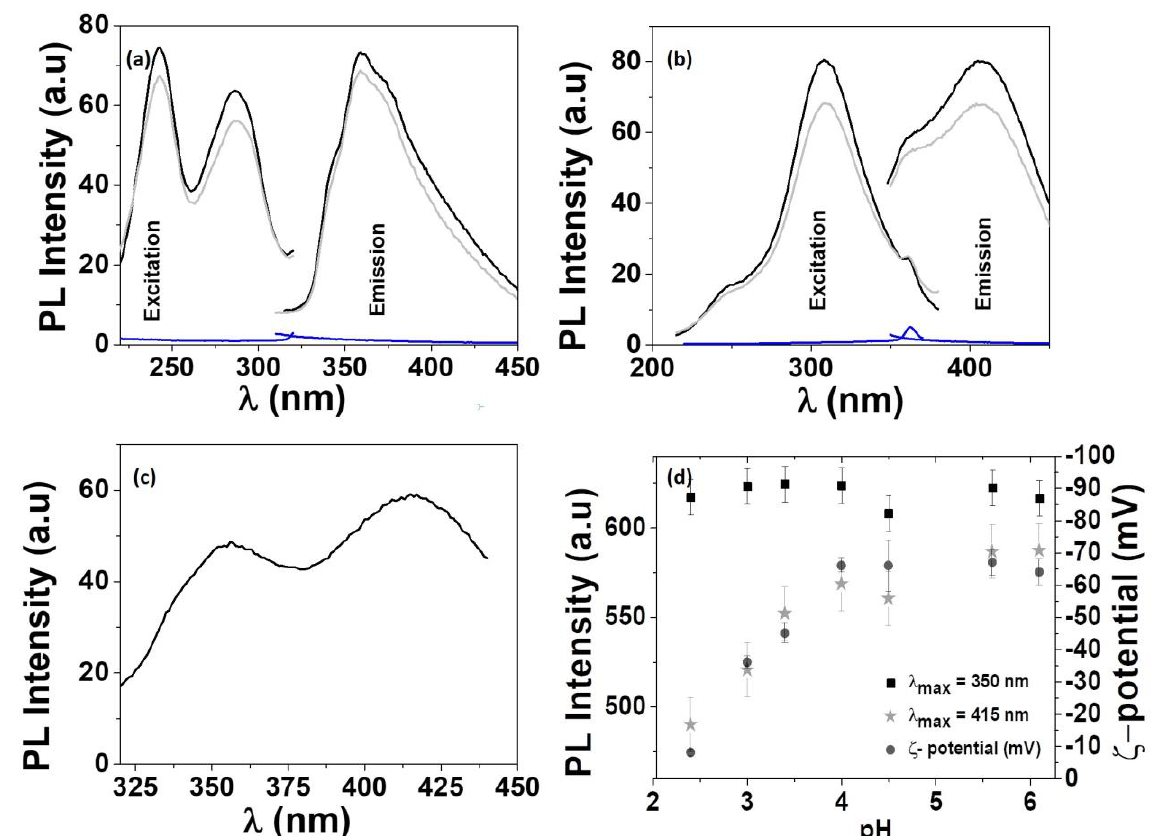
Figure 3. Emission and excitation spectra of the AuNCs before (black curve) and after dialysis (gray curve) for ( a ) the UV emission (360 nm) excited at 250 nm, and ( b ) visible emission (415 nm) excited at 315 nm. In blue is the PL spectra of the NaOH water solution at the concentration of 20 mmol L − 1 . ( c ) Emission with excitation at 285 nm, where both the PL emission peaks are present at the wavelengths of 360 nm and 415 nm. ( d ) Modulation of the ζ -potential (circular points) and PL intensity at the wavelengths of 360 nm (square points) and 415 nm (star points) depending on the pH of the water environment. The error bars were evaluated by considering four samples produced in independent synthesis processes. The pH was controlled by the addition of